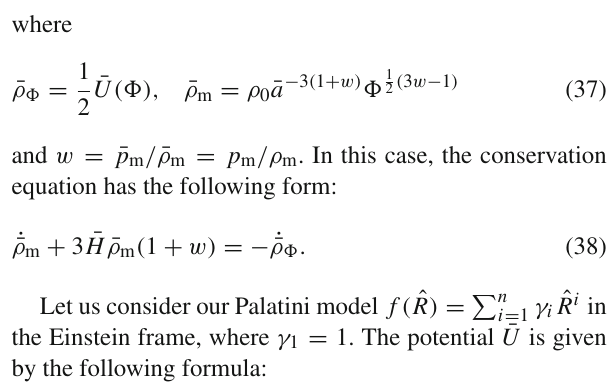
Fig. 9 The evolution of V ( ¯ a ) in the Einstein frame in the case when the evolution of the universe starts from the generalized sudden singu- larity. For illustration it is assumed that f ( ˆ R ) = ˆ R + γ ˆ R 2 + δ ˆ R 3 . This figure corresponds to Fig. 11. The blue dashed line presents the gener- alized sudden singularity. Note that the undesirable freeze singularity disappears. The potential V ( a ) is expressed in units of 10 4 km 2 s 2 Mpc 2